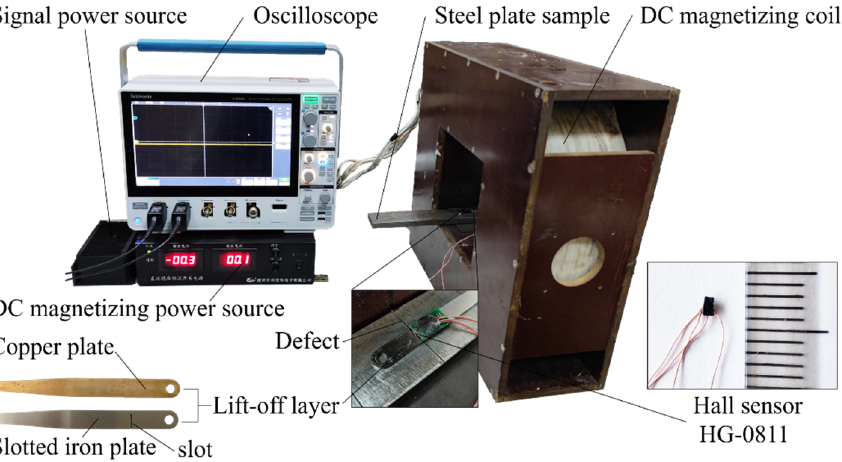
Figure 15. Schematic of the experimental setup for SFLL-MFL detection. The Hall element was fixed on the slotted iron plate and aligned with the centerline of the slot. The slotted iron plate, which was close to the steel plate sample, scanned the defect on the steel plate sample several times. Stable MFL signal waveforms were obtained on the oscilloscope. Then the Hall element was fixed on the copper plate and scanned the defects in the same way. The signal waveforms of the copper plate were obtained on the oscilloscope. The experimental results are shown in Figure 16. It can be seen that the signal amplitude of the copper plate lift-off layer is 29 mV, while the signal amplitude of the slotted iron plate lift-off layer is 98 mV, which is about 3.4 times that of the copper plate lift-off layer. The enhancement effect of the MFL signal in the SFLL-MFL method is obvious.